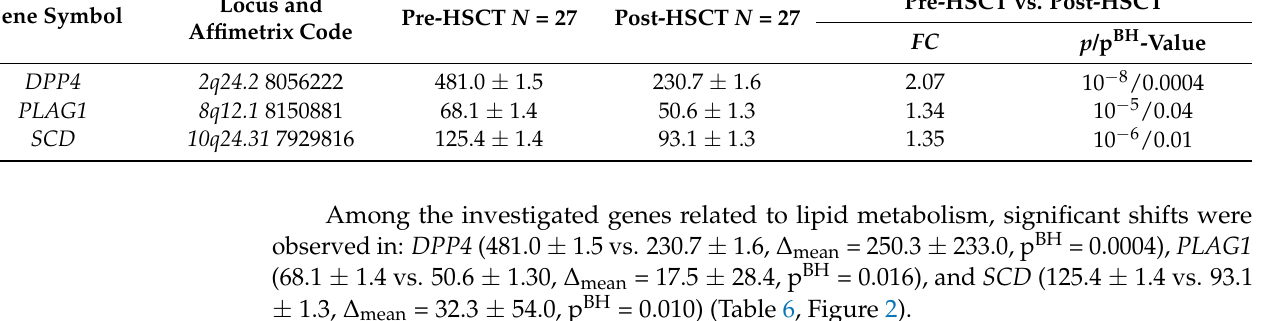
Table 7. Selected correlations between expressions (or its change Δ mean and relative change Δ mean(rel) ) of genes associated with lipid metabolism and lipid parameters in children treated with HSCT. Lipid Metabo- lism Pa- rameter Gene Pre-HSCT Gene Expres- sion and Pre-HSCT Lipid Metabolism Parameters Post-HSCT Gene Expres- sion and Post- HSCT Lipid Metabolism Pa- rameters Pre-HSCT Gene Expression and Post-HSCT Li- pid Metabolism Parameters Gene Expres- sion Change ( Δ mean ) and Post- HSCT Lipid Metabolism Pa- rameters Gene Expression Rel- ative Change ( Δ mean(rel) ) and Post-HSCT Lipid Metabolism Parame- ters (%) Spearman’s Correlation Coefficient r and p /p BH -Value TC